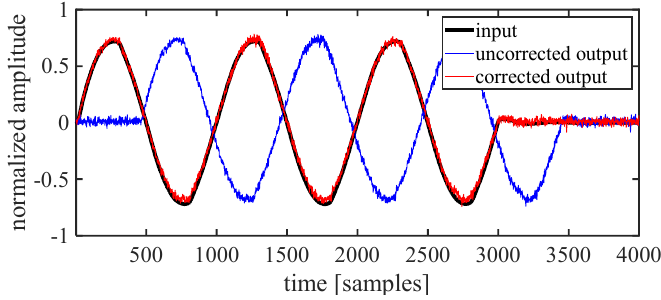
Figure 5. Synchronization of the input and output data.